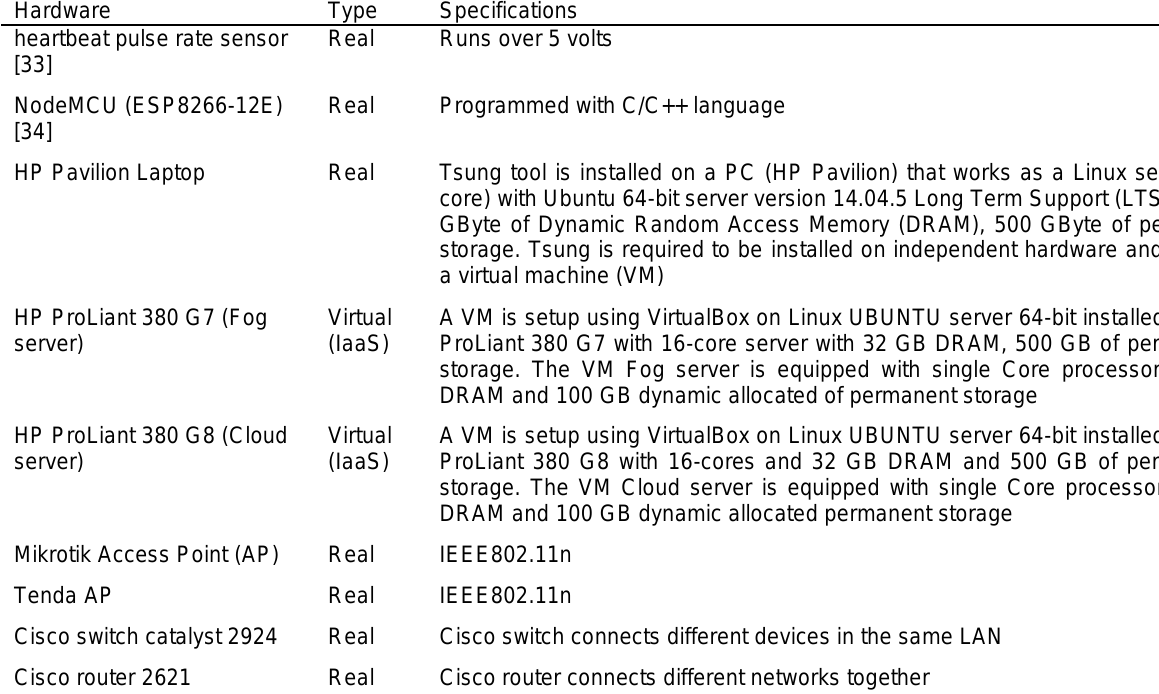
Table 1. Hardware used in IoT-F2CDM-LB architectures